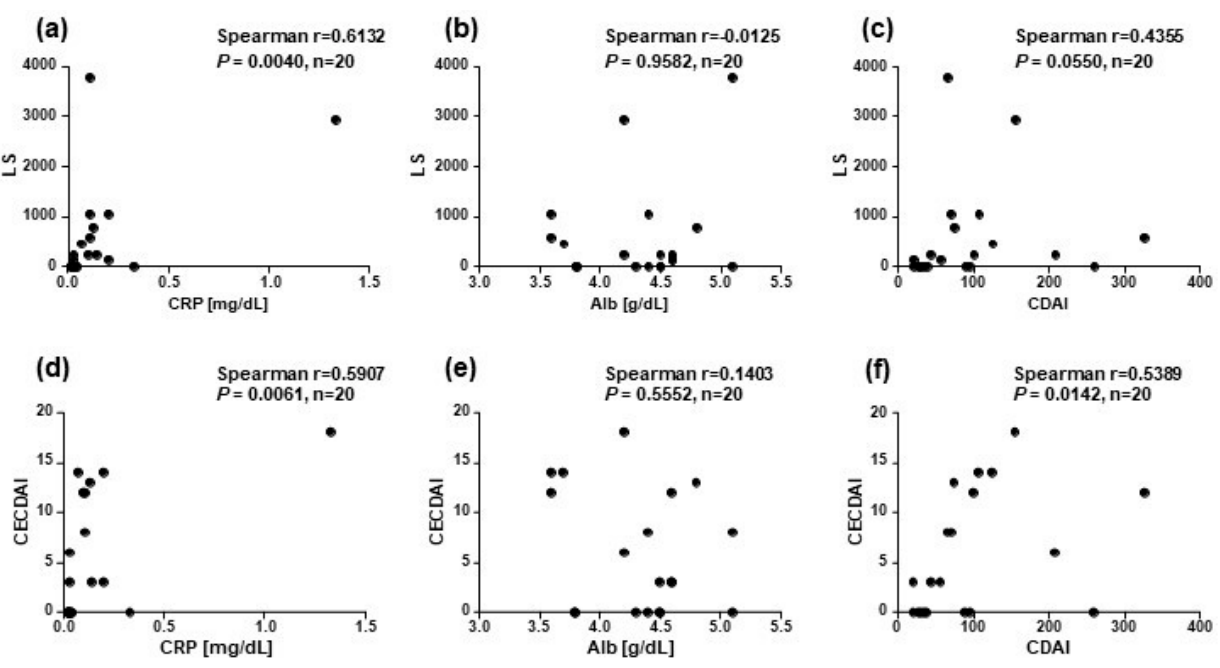
Figure 5. Correlation of CE scores with Crohn’s disease activity markers. The correlations between the LS and ( a ) CRP level, ( b ) Alb level, and ( c ) CDAI score was examined (n = 20). A correlation between the CECDAI score and ( d ) CRP level, ( e ) Alb level, and ( f ) CDAI score was examined (n = 20); P - value is the result by Spearman’s correlation coefficient.